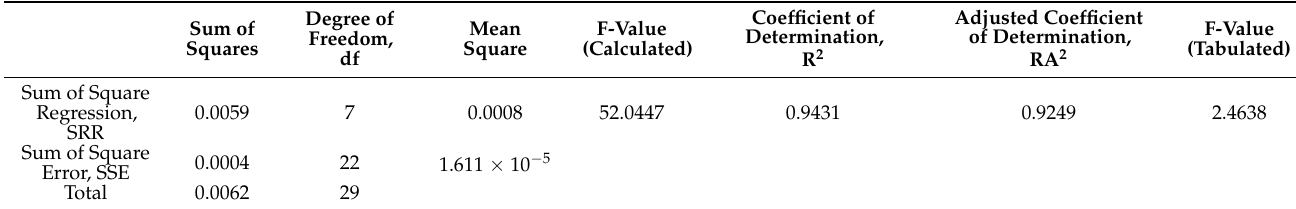
Table 5. ANOVA of response surface model for MGSS conformal cooling